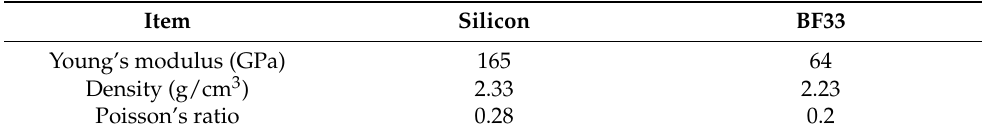
Table 5. Material properties in FEA